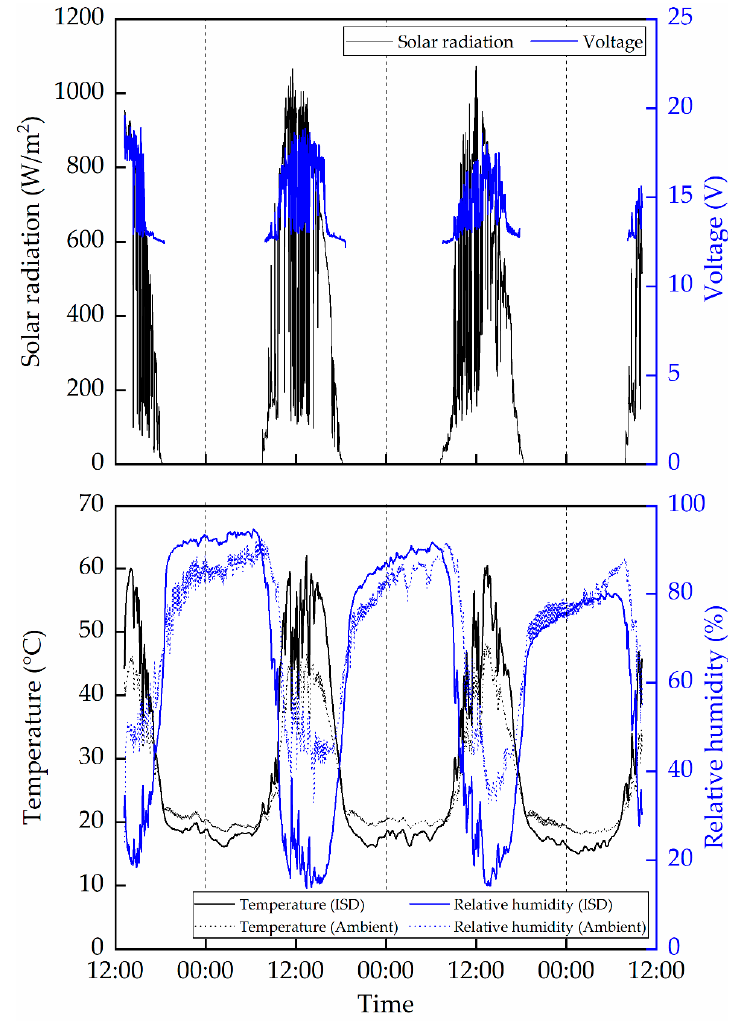
Figure 6. Solar radiation and voltage generated by the PV modules ( top ) and temperature and relative humidity in the ISD and ambient conditions ( bottom ) during the drying experiment on 8–11 December 2016.